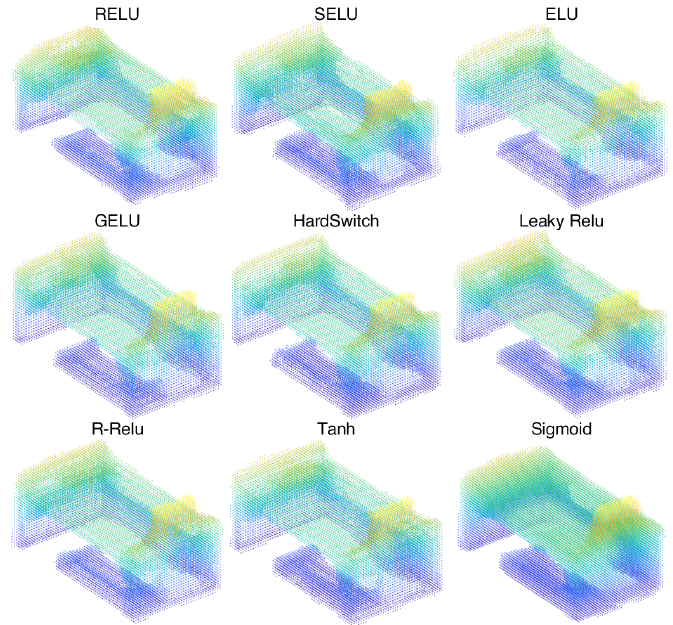
Figure A2. The compression effects of 3D point clouds with different activation